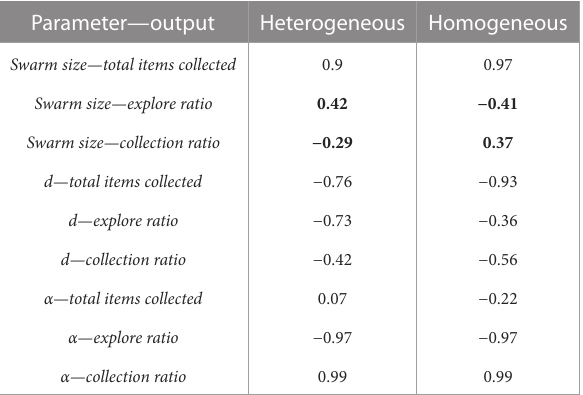
TABLE3 LHAcorrelationvaluesfortheDPS.Valuesinboldrepresenta bigdifference,greaterthan0.5,betweenheterogeneousand